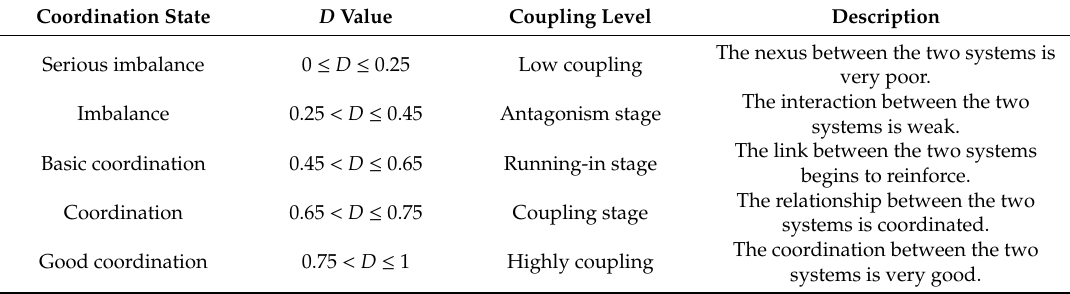
Table 3. Classification standard and the types of coupling coordination